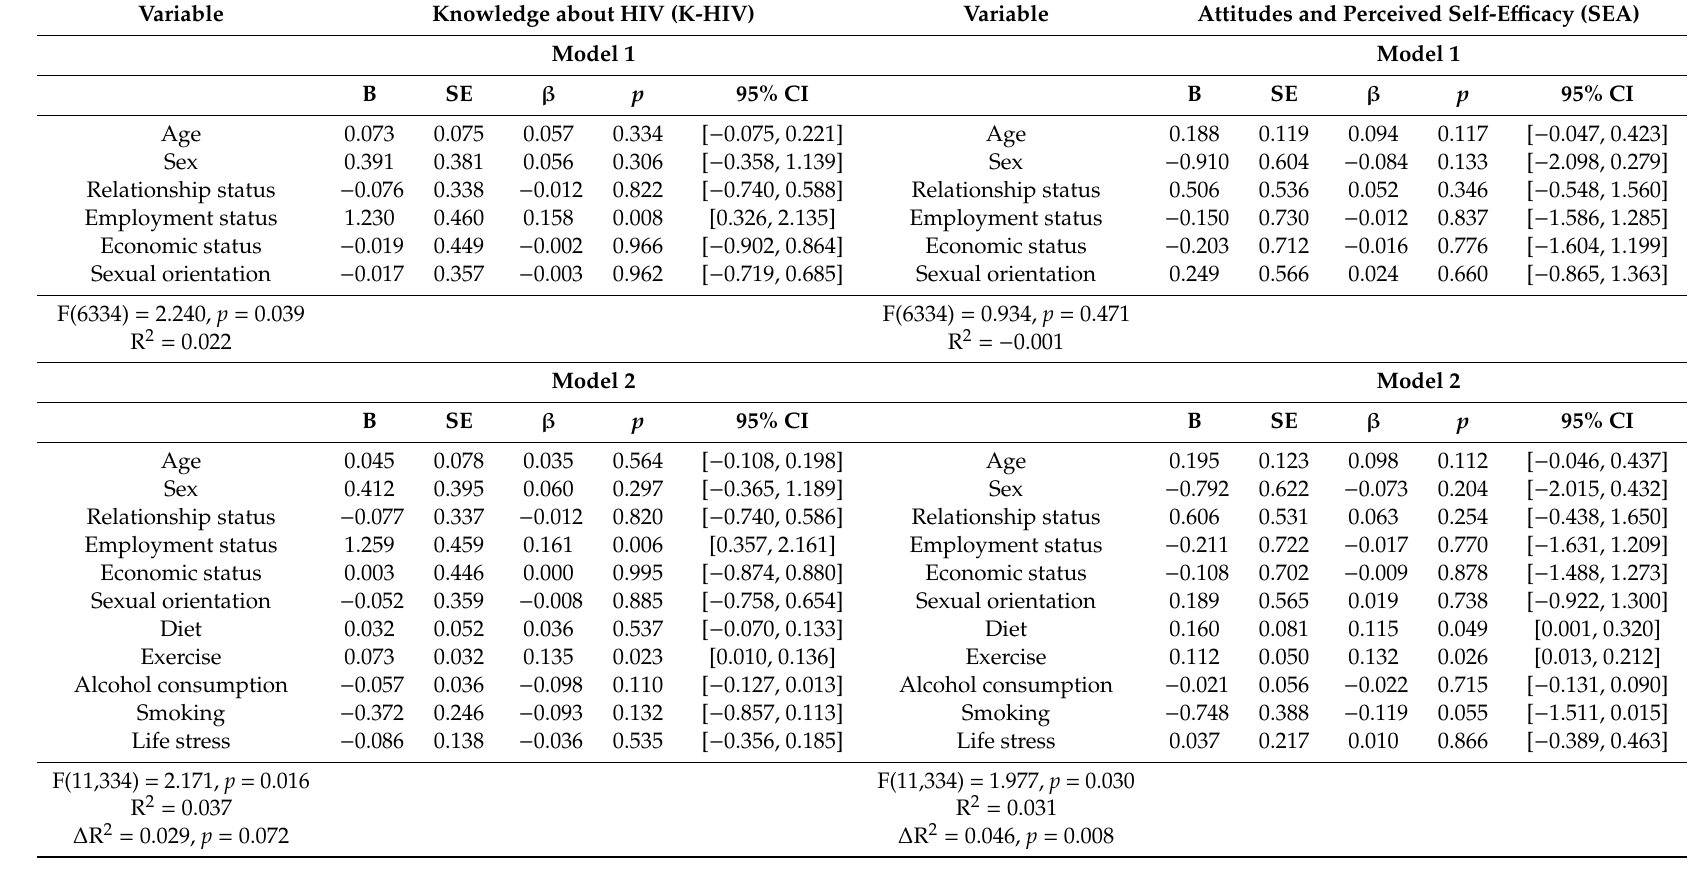
Table 5. Predictive value of personal and lifestyles variables on K-HIV and SEA dimensions of HIV risk factors. Variable Knowledge about HIV